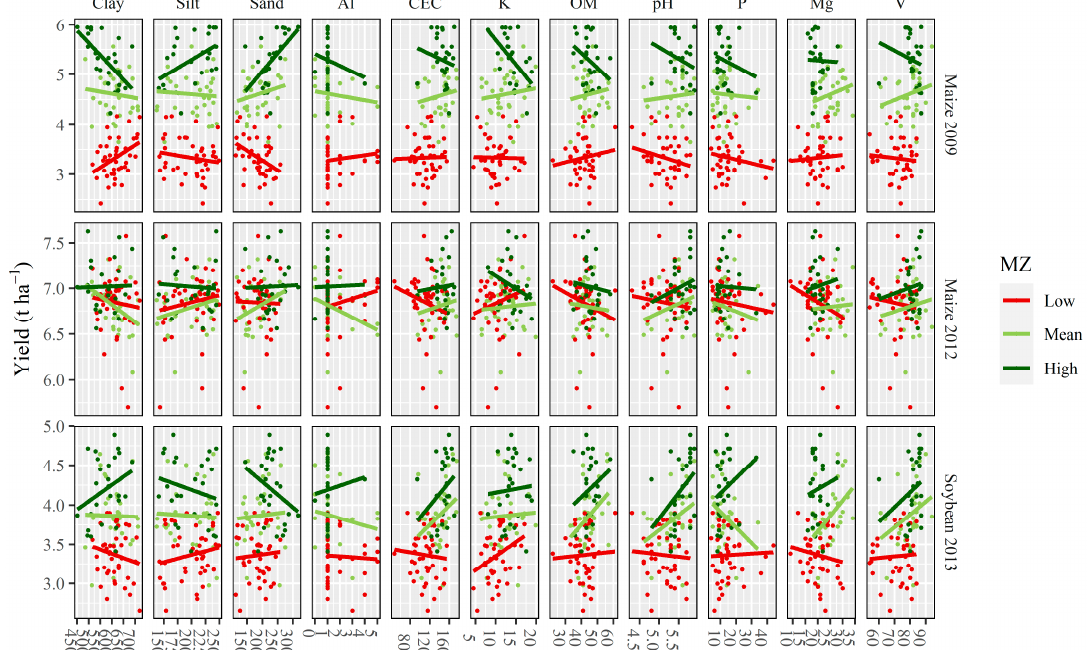
Figure 11. Chemical variables and soil texture in relation to productivity for each management zone and